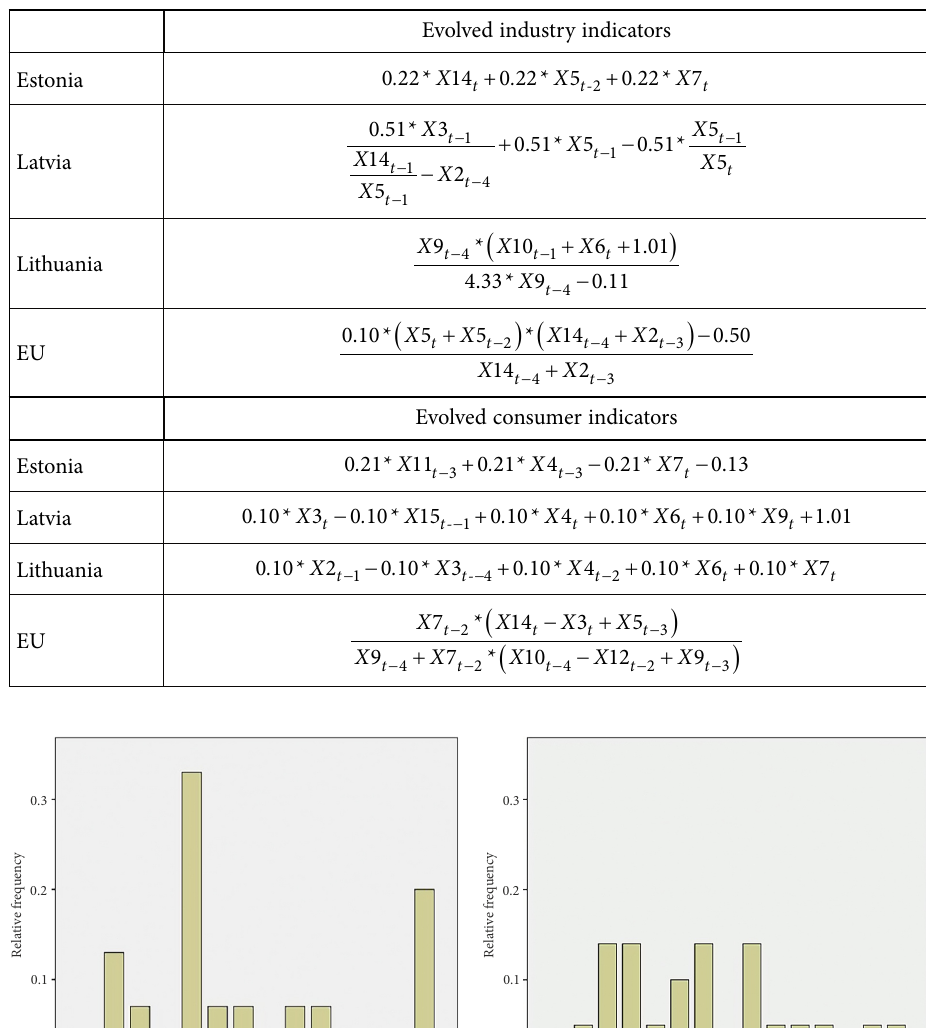
Table 2. Evolved industry and consumer confidence indicators